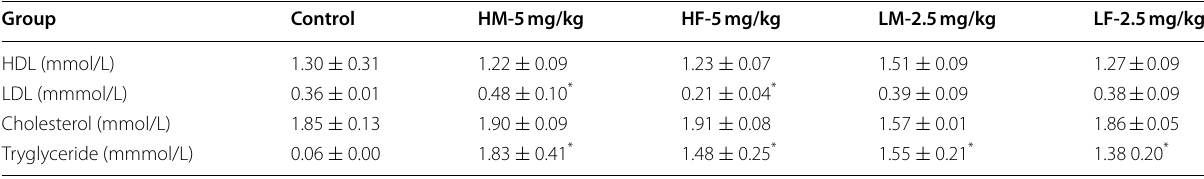
Table 4 Serum lipid profile in male and female rats treated with 2.5 mg/kg and 5 mg/kg dose of Mystomate4 ® for 3 months compared with control rats administered the